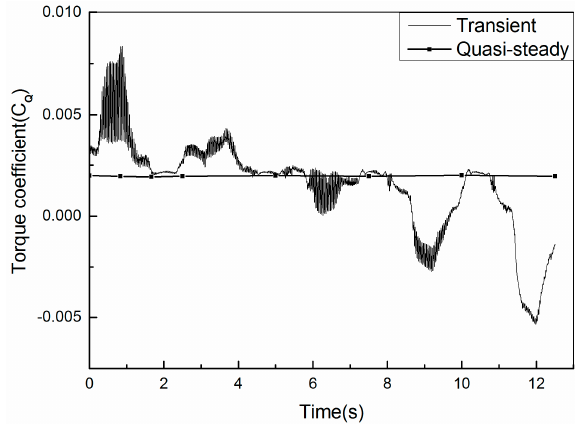
Figure 9. Time history of the rotor torque coefficient.